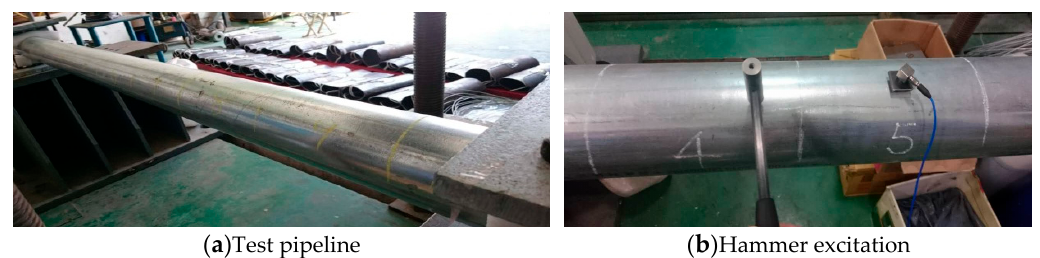
Figure 14. Test model of actual pipeline. ( a ) Test pipeline; ( b ) Hammer excitation.